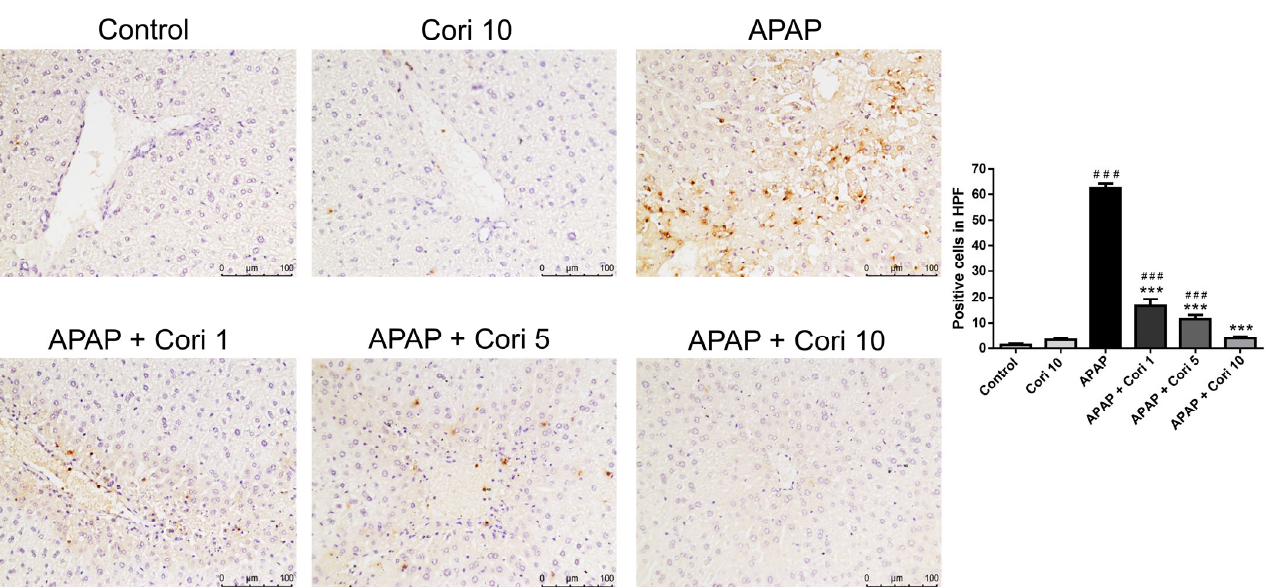
Figure 3. The effects of corilagin on macrophage infiltration in acetaminophen ‐ induced hepatic in ‐ jury. Animals were injected with APAP (300 mg/kg) or equal volume of saline (control), and treated with corilagin (0, 1, 5, or 10 g/kg) (200×). Each value represents mean ± SEM; n = 6 for each group. ## p < 0.01, ### p < 0.005 vs. control group; *** p < 0.005 vs. APAP group.